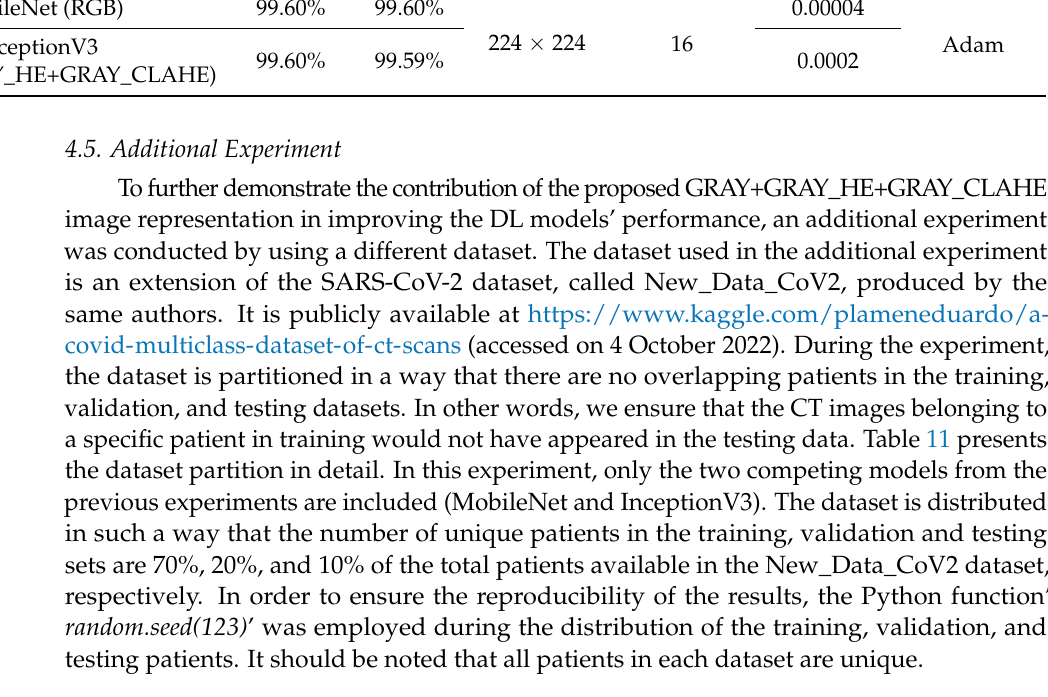
Table 11. Dataset partition of the New_Data_CoV2 dataset used in the additional